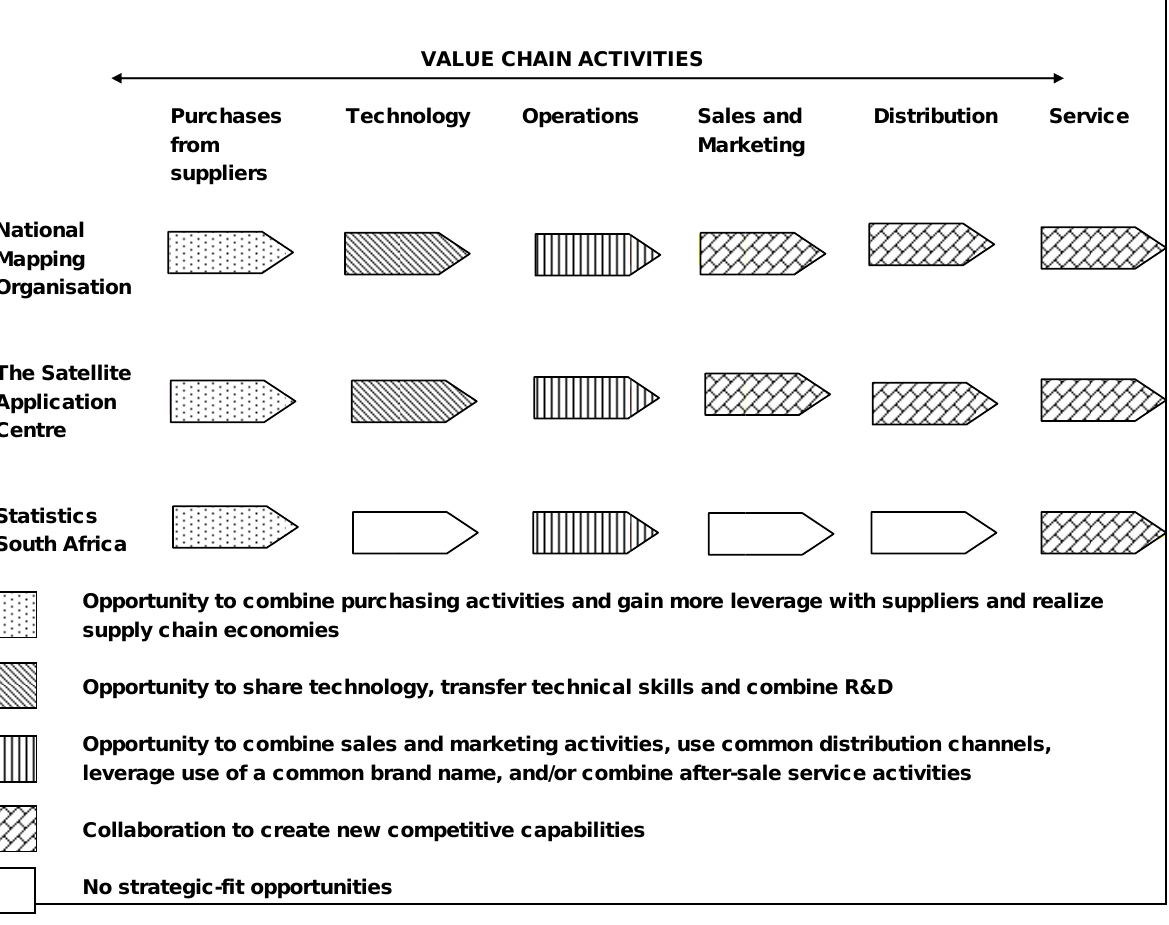
Figure 3: Strategic value chain synergies between the NMO, SAC and Stats